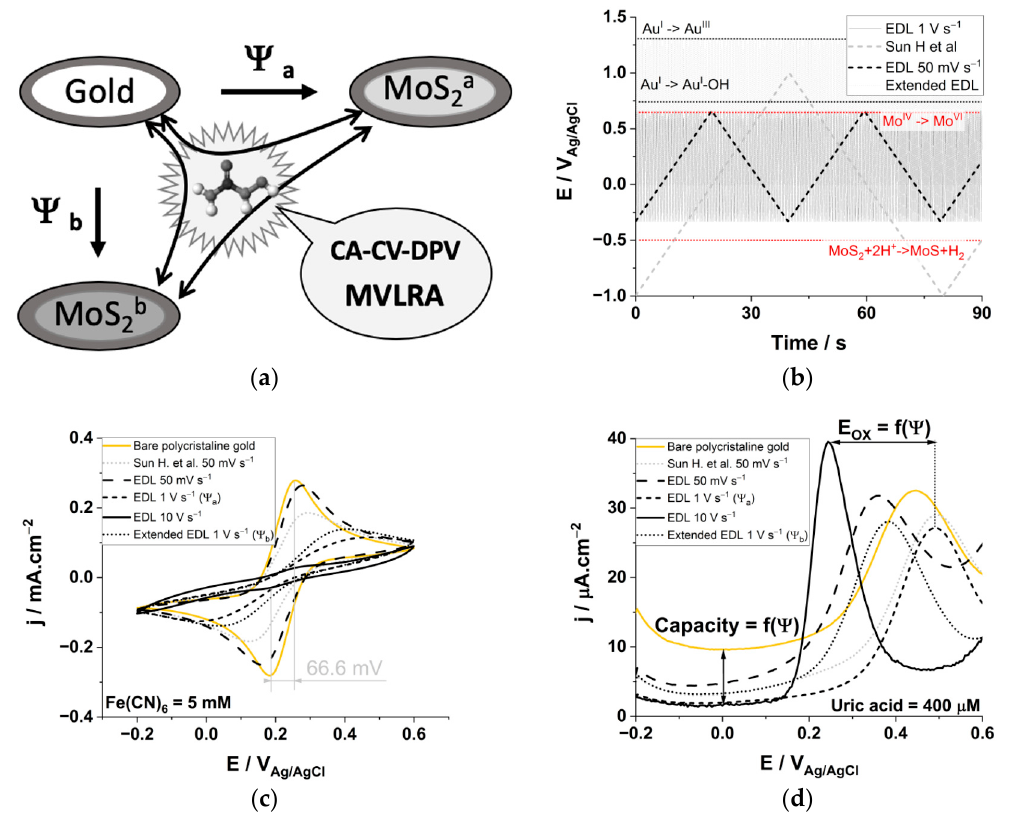
Figure 1. ( a ) Commercial gold electrodes are modified with MoS 2 using different waveform polarization (Y n = a,b ) and the concentration of hydroxyurea (HU) is estimated from multiple electro-analytical techniques (ca., chronoamperometry {CA}, cyclic voltammetry {CV} and differential pulse voltammetry {DPV}) using multivariate analytical tools. ( b ) The triangular waveforms used for the electro-deposition of MoS 2 on the gold electrode, MoS 2 redox reaction occurs simultaneously for polarization potential below − 0.5 V Ag/AgCl and above 0.7 V Ag/AgCl (red dotted lines). For polarization potential > 0.8 V Ag/AgCl , gold hydroxylation and oxidation occur (black dotted lines). ( c ) Cyclic voltammograms of the electrodes in the presence of 5 mM ferrocyanide/ferricyanide at 0.1 V s − 1 in PBS pH 7.4 at a bare electrode (yellow), a MoS 2 modified electrodes deposited by CV between (Grey dotted, Sun. H et al.) − 1/+1 V Ag/AgCl , (“EDL”) − 0.3/+0.7 V Ag/AgCl , (“Extended EDL”) 0/+1.4 V Ag/AgCl . ( d ) Differential pulse voltammograms corresponding to the electrochemical signature of 400 mM uric acid in PBS pH 7.4.